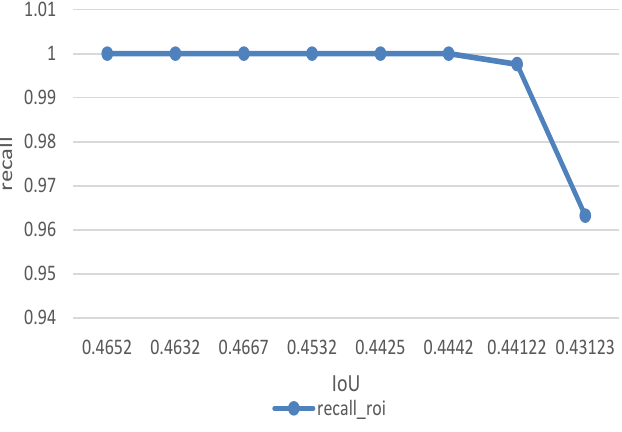
Figure 16. The relationship between IoU and